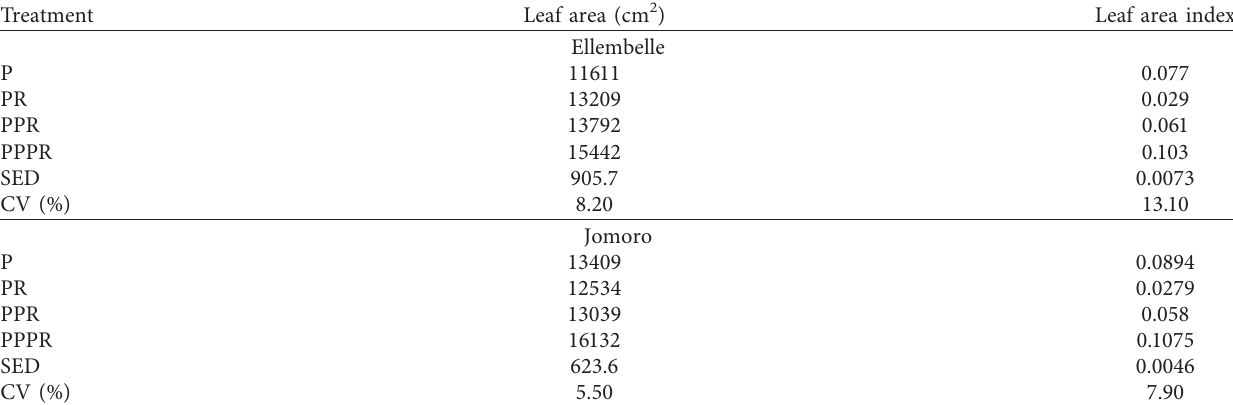
Table 11: Effect of different plantain population on leaf area and leaf area index of plantain at Ellembelle and Jomoro.